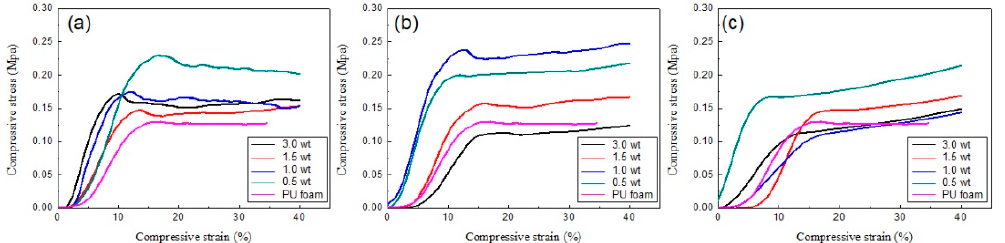
Figure 7. Compressive stress of PU foam and PU composite foams with different composition of ( a ) silica aerogels, ( b ) silica nanoparticles, and ( c ) silica produced by sol-gel reaction.